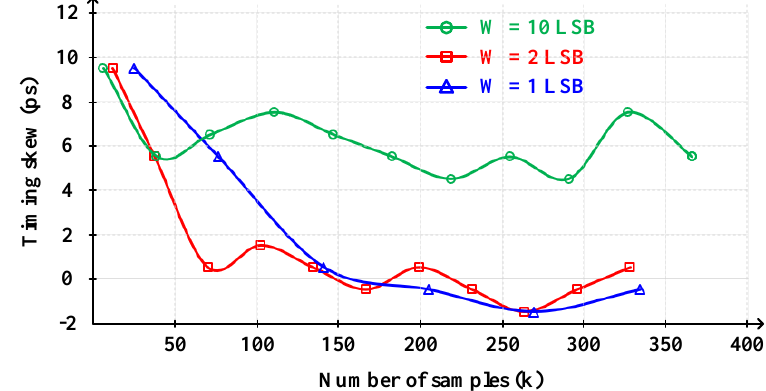
Figure 11. Relationship between window width, calibration accuracy and convergence time.